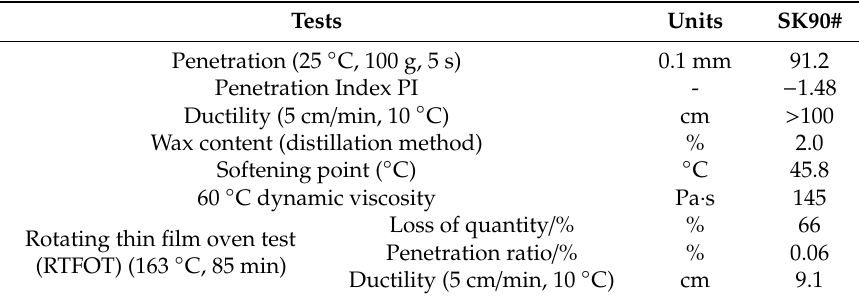
Table 1. Physical properties of the asphalt binder.